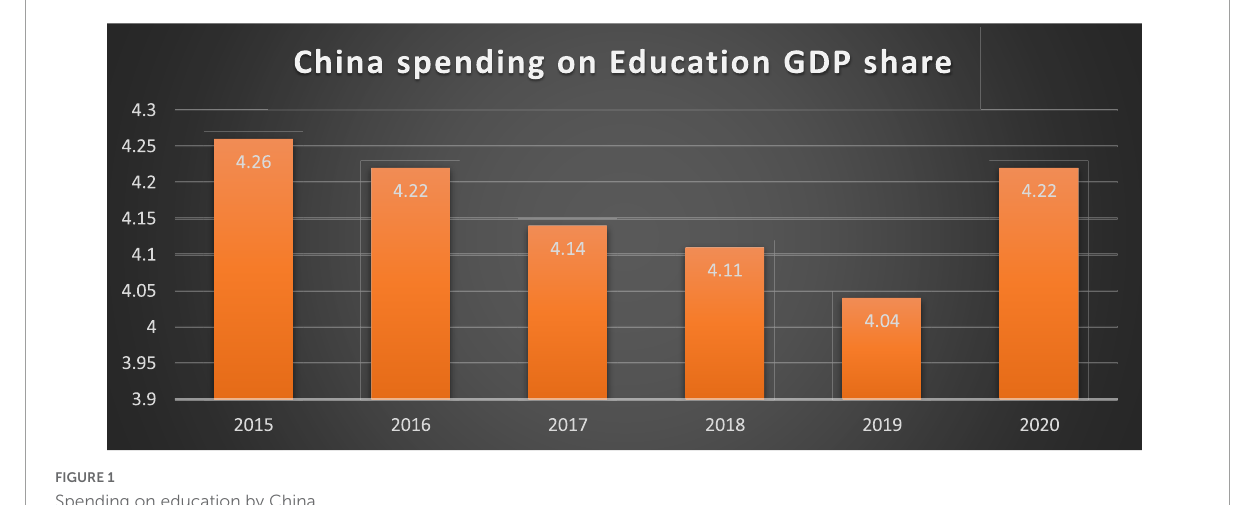
FIGURE1 Spending on education by China.